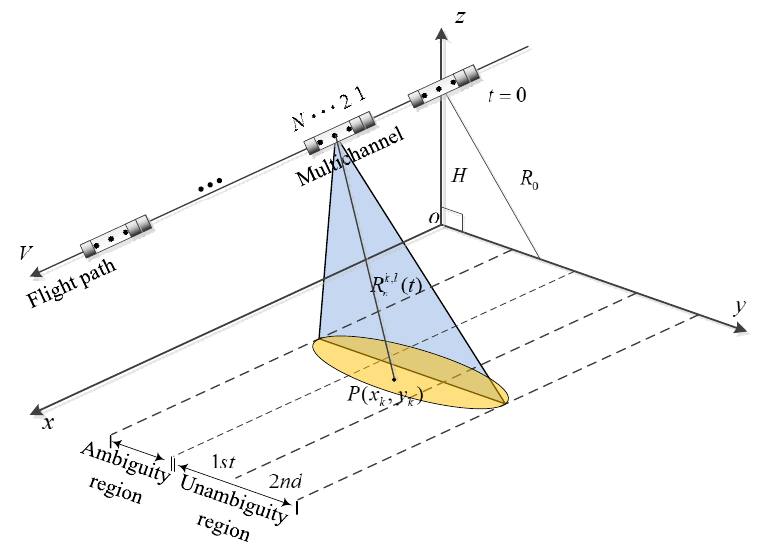
Figure 1. Multi-channel SAR system.